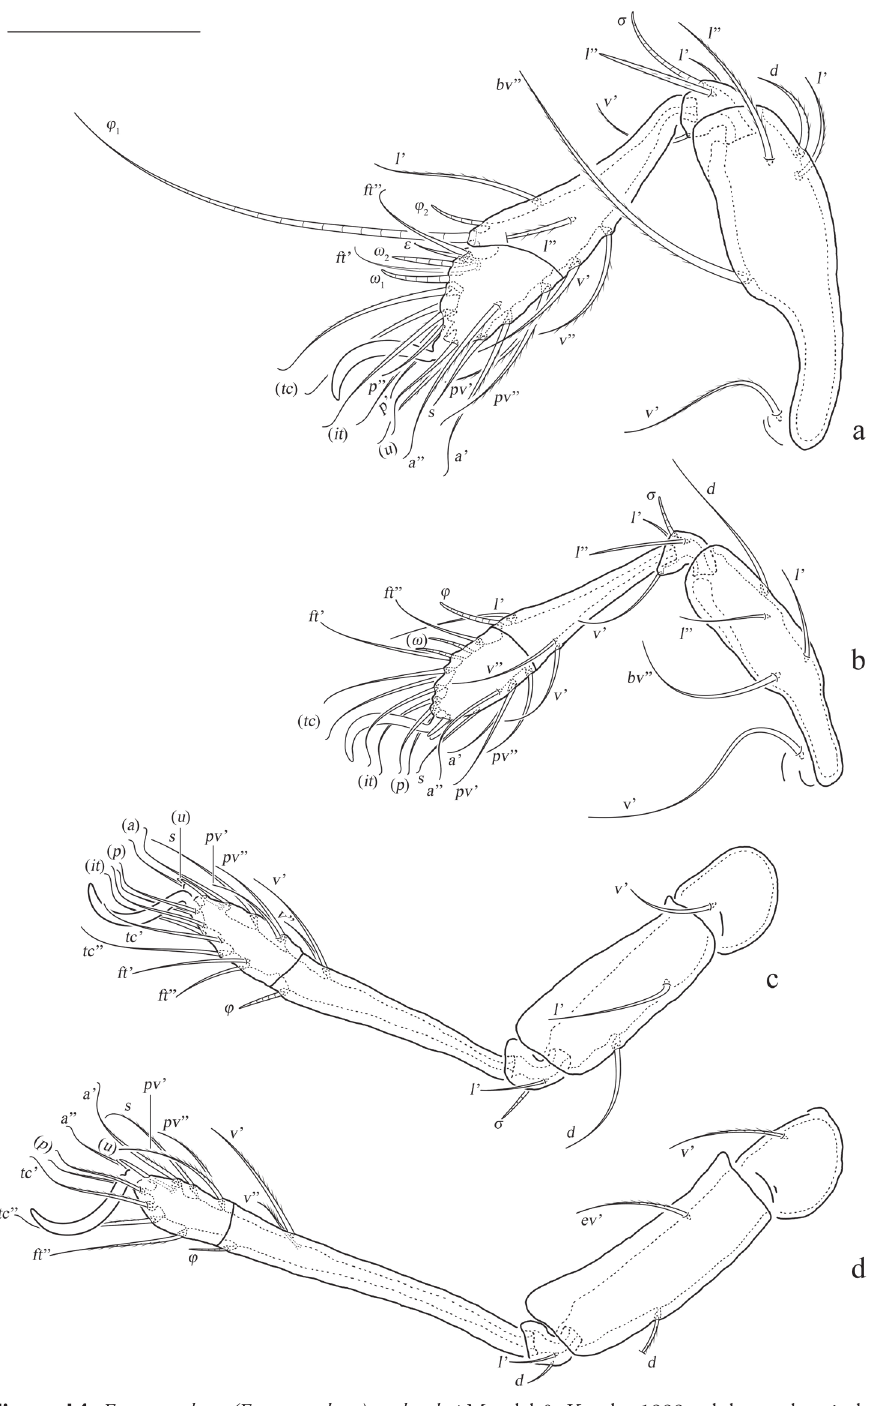
Figure 14. Eurostocepheus (Eurostocepheus) mahunkai Mondal & Kundu, 1999, adult: a subcapitulum, ventral view b left palp, abaxial view c left chelicera, adaxial view. Scale bars: 50